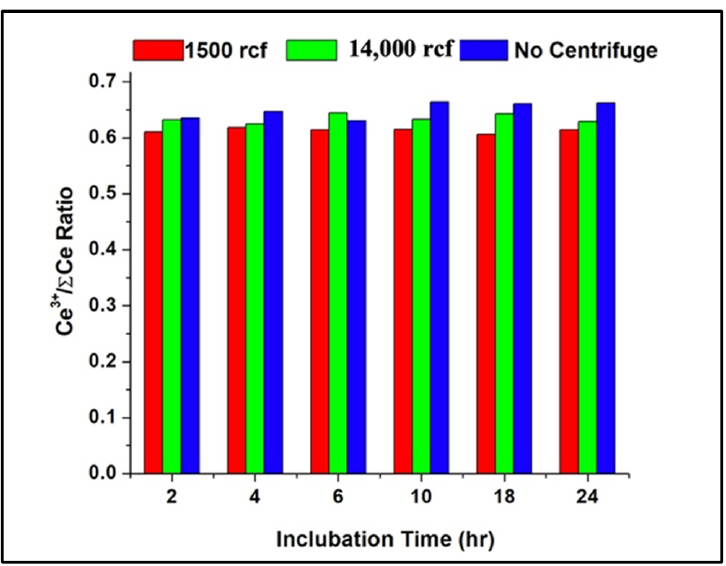
Figure 3. The Ce 3+ /Ce 4+ of nanoceria extracted at 1500 rcf, 14,000 rcf, and no centrifuging from S5NBCe glass melted with sodium tetraborate decahydrate for 1 h at 1100 °C.